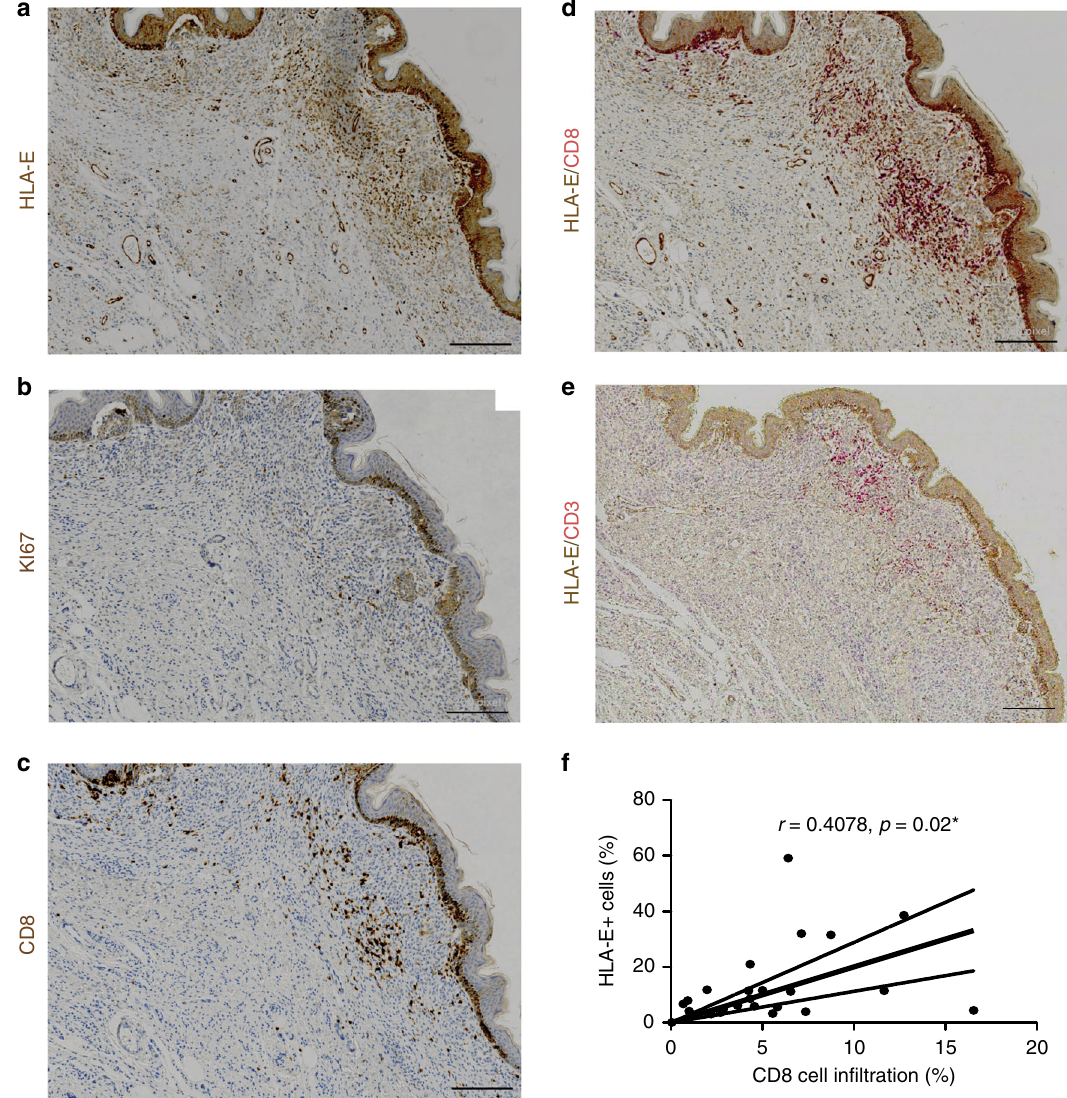
Fig. 6 HLA-E expression by senescent cells in human melanocytic nevi. Formalin- fi xed paraf fi n-embedded tissue arrays of human melanocytic nevi were analysed by immunohistochemistry using ( a ) HLA-E (MEM-E/02), ( b ) Ki67, ( c ) CD8 speci fi c antibodies. d Double-staining with antibodies for HLA-E (brown) and CD8 (red) showing CD8 + in fi ltrates surrounding areas with strong HLA-E expression. e Double-staining with HLA-E (brown) and CD3 (red) showing that part of the CD8 + in fi ltrates are also positive for CD3, identifying them as CD8 + T cells. Scale bar = 50 μ m. f Correlation between the frequency of HLA-E + cells and CD8 + in fi ltrates in human melanocytic nevi ( n = 24) assessed by Spearman